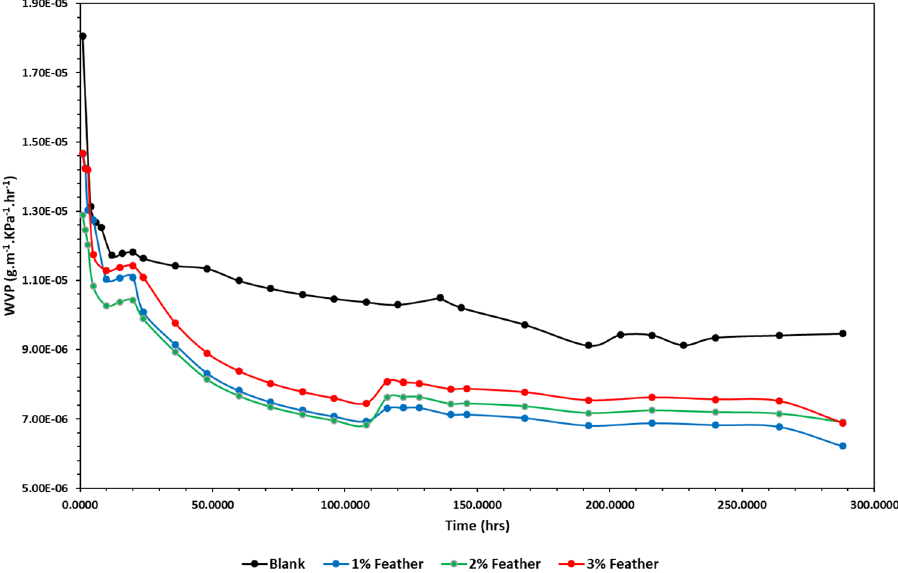
Figure 10. The WVP of none coated HSP (blank) and coated HSP with SEDCFs at different concentrations of SEDCFs (1%, 2% and